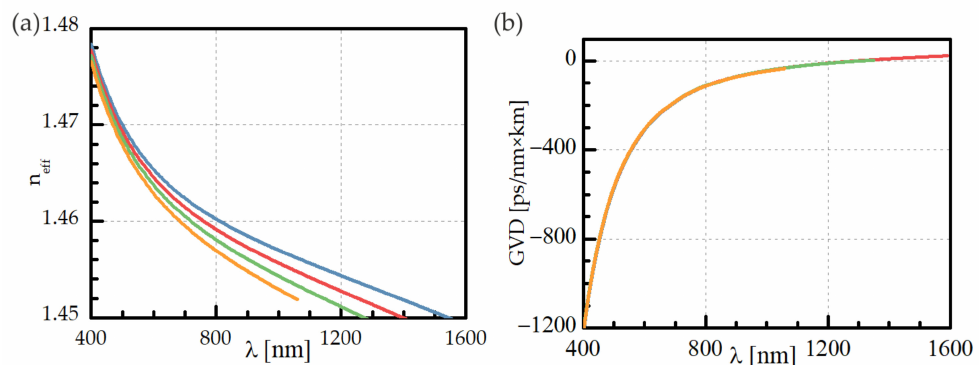
Figure 1. ( a ) The effective refractive index value, plotted for fundamental mode (blue) and a few higher-order modes: LP 11 (red), LP 02 and LP 21 (green), and LP 31 and LP 12 (orange); ( b ) group velocity dispersion (GVD) for different modes: LP 01 and LP 11 (light red), LP 02 and LP 21 (green), and LP 12 and LP 31